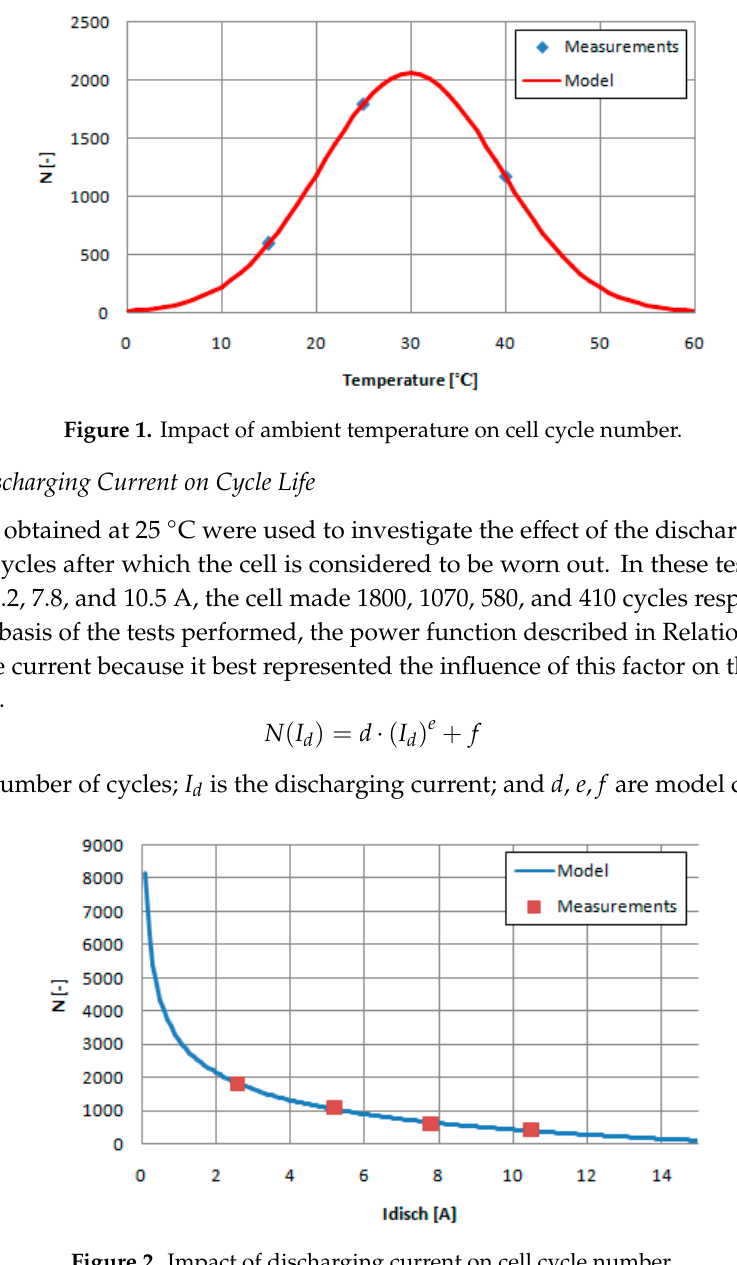
Figure 2. Impact of discharging current on cell cycle number. 185